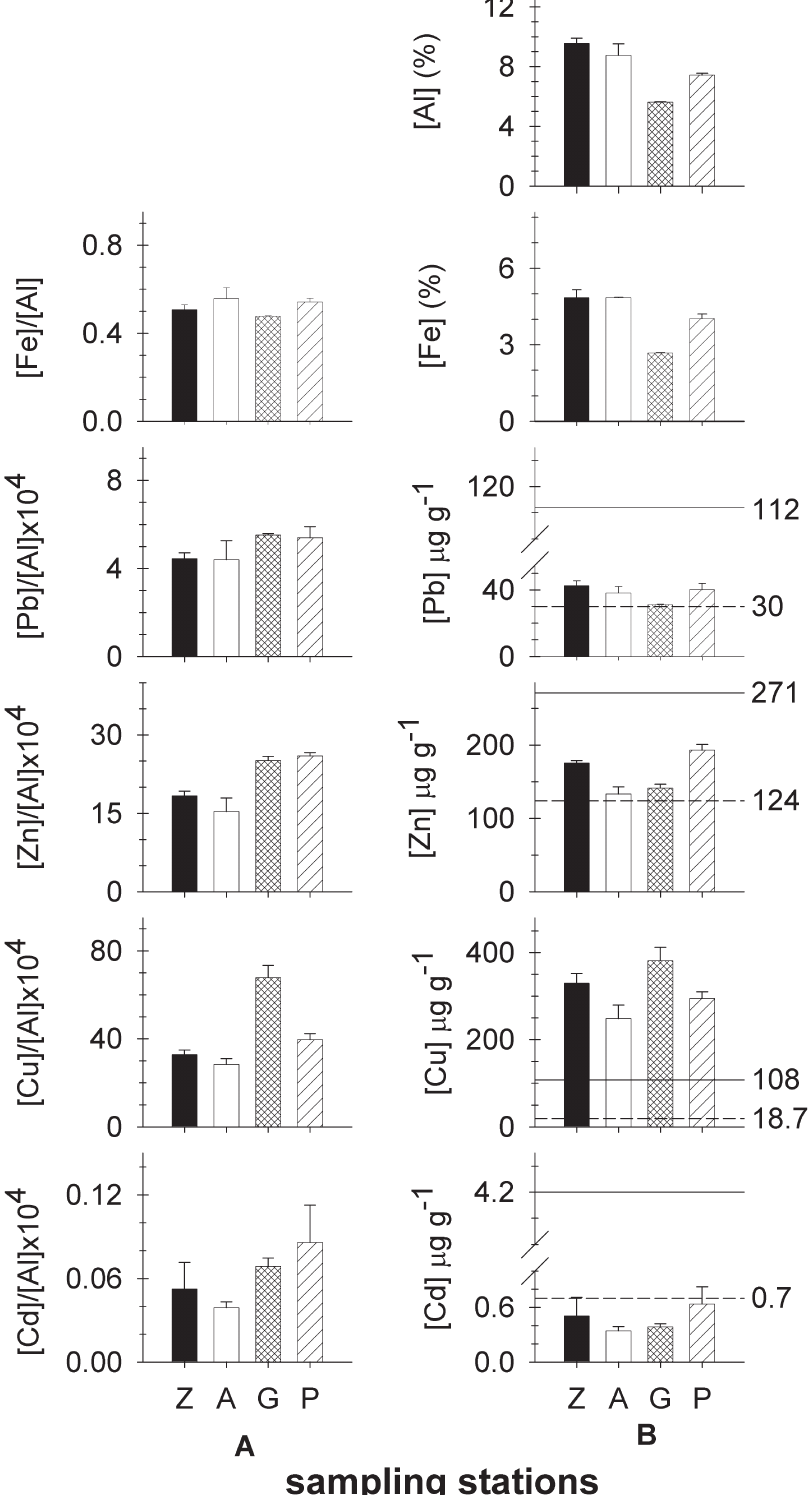
Fig . 2. – Metal concentrations ( [ al ] , [ Fe ] % and [ Zn ] , [ cu ] , [ cd ] µg g -1 dry weight ± s.d.) in the top 5 cm of sediment (n =3 samplings at each station) in Águas de Moura channel. s.d.- standard deviation. (a) normalized metal concentrations to al; (B) non-normalized metal concentrations. sediment quality guidelines for Florida coastal waters (MacDonald et al., 1996): _ _ _ t.e.l. (threshold effects level); ____ P.e.l. (probable effects